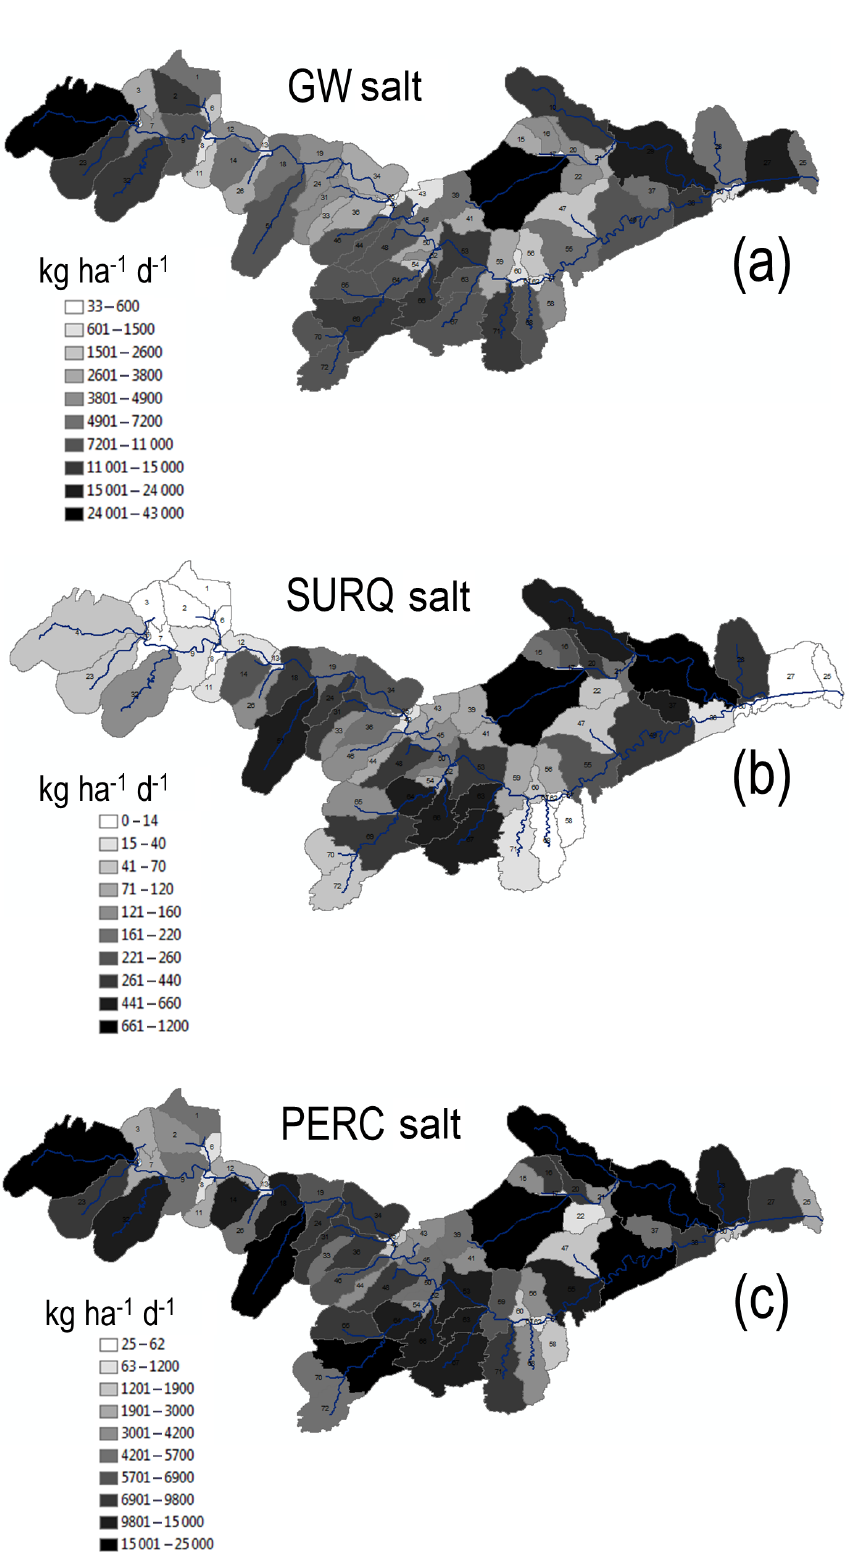
Figure 9. Average daily loading (kgha − 1 ) of salt by subbasin to (a) stream network via groundwater discharge, (b) stream network via surface runoff, and (c) groundwater via soil